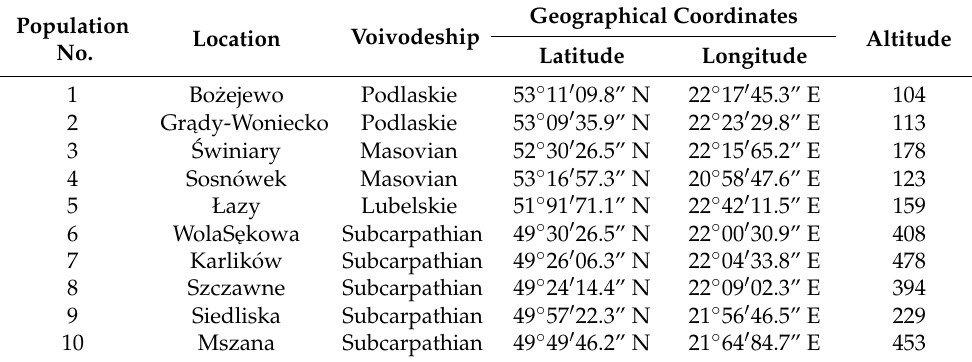
Table 5. The geographical coordinates of origin of the studied nettle